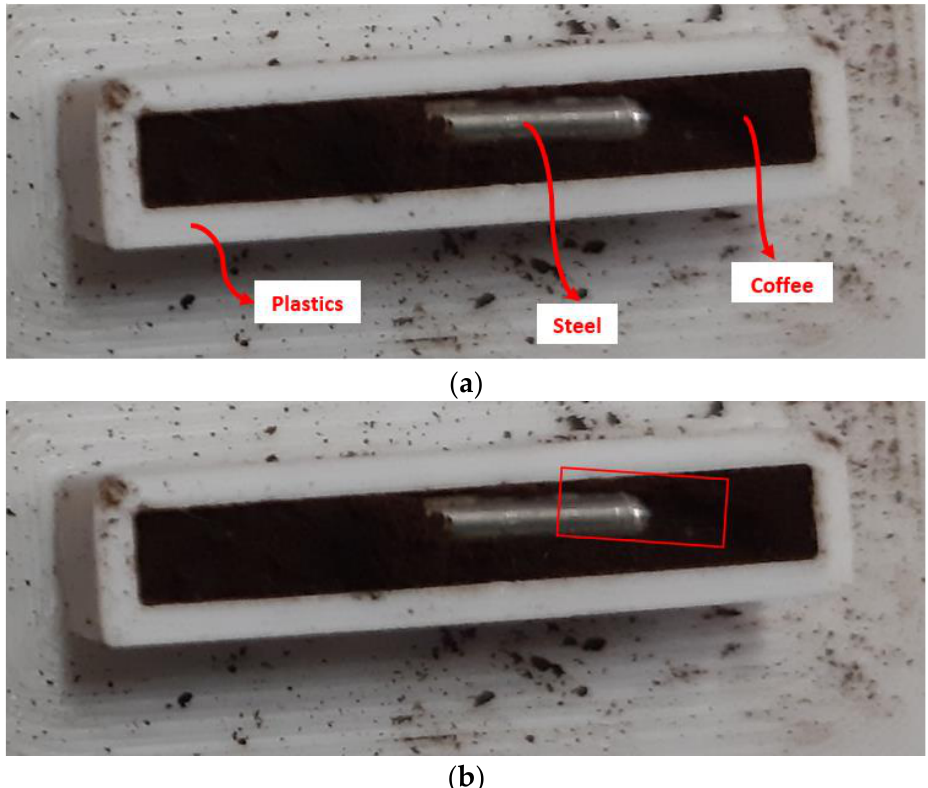
Figure 14. ( a ) Visible image of the phantom used for X-ray imaging measurements: a plastic container with coffee powder and a steel sample. ( b ) The red rectangular line highlights the scanning area.